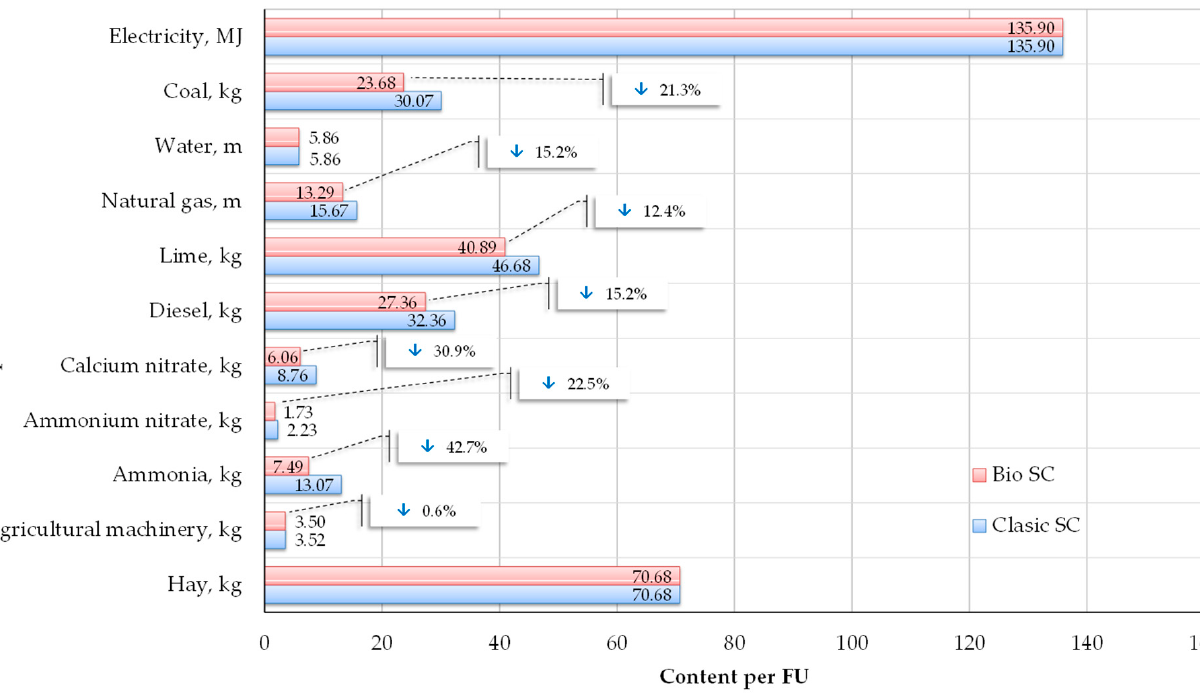
Figure 3. Data on basic stocks of milk production per FU.